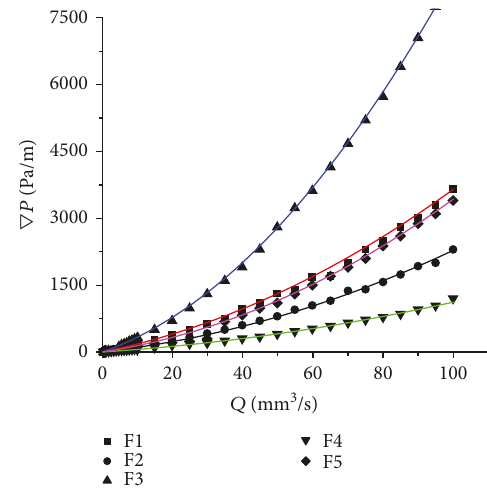
Figure 5: Relationship between pressure gradient and fl owrate in the 90 °